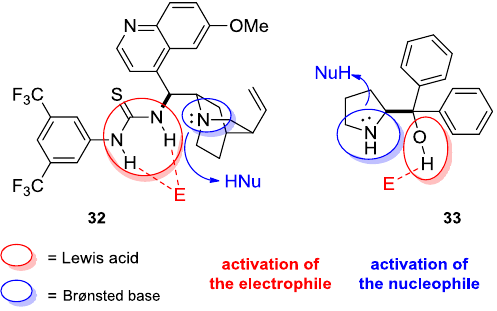
Figure 10. Examples of bifunctional, non-covalent organocatalysts.